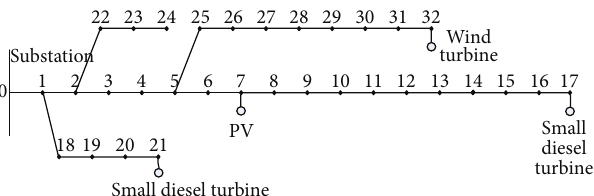
Figure 3: Schematic diagram of the IEEE 33-bus system with 4 DG units.